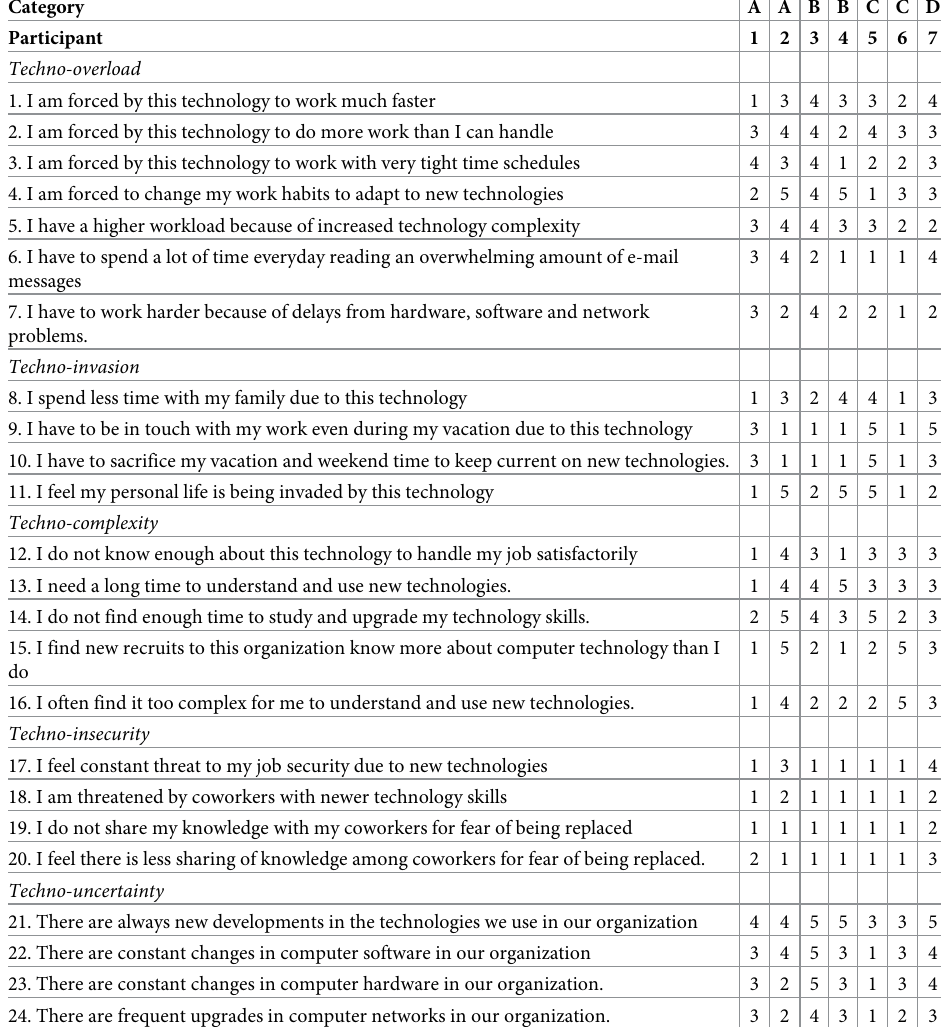
Table 4. Rating for each item on Technostress in the four categories of the participants (n = 7).